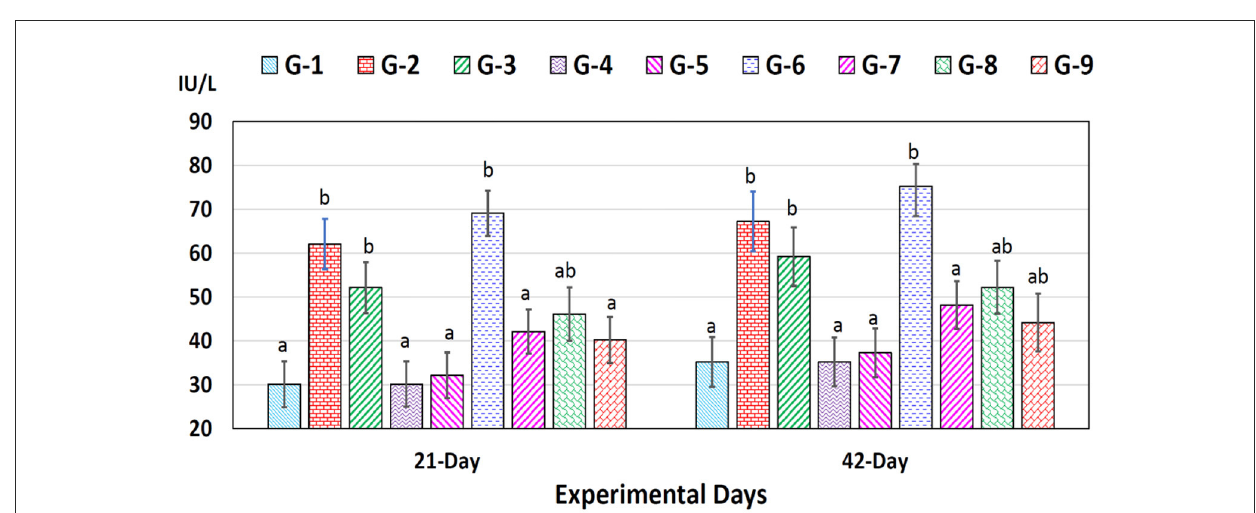
FIGURE2 Alanine aminotransferase (ALT) in broiler chicks on 21 and 42 experiment days administered arsenic, chromium, vitamin E, and bentonite alone or in combinations. Bars (mean ± SE) having dissimilar letters under a specific experimental day vary significantly ( p < 0.05). Chromium, arsenic, and vitamin E were given @ 270, 50, and 150mg.kg − 1 , respectively, while bentonite was administered @ 5%. G1 = Group 1: Control (negative); G2 = Group 2: Chromium; G3 = Group 3: Arsenic; G4 = Group 4: Vitamin E; G5 = Group 5: Bentonite; G6 = Group 6: Chromium + Arsenic; G7 = Group 7: Chromium + Arsenic + Vitamin E; G8 = Group 8: Chromium + Arsenic + Bentonite; and G9 = Group 9: Chromium + Arsenic + Vitamin E + Bentonite.